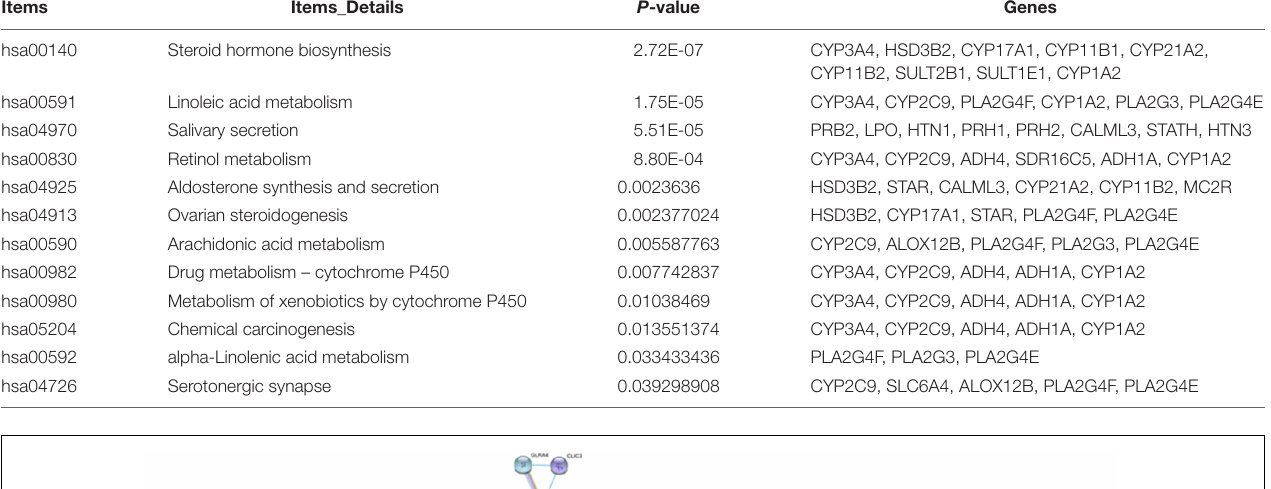
TABLE 4 | KEGG pathway enrichment of dysregulated DEGs in melanoma ( p < 0.05). Items